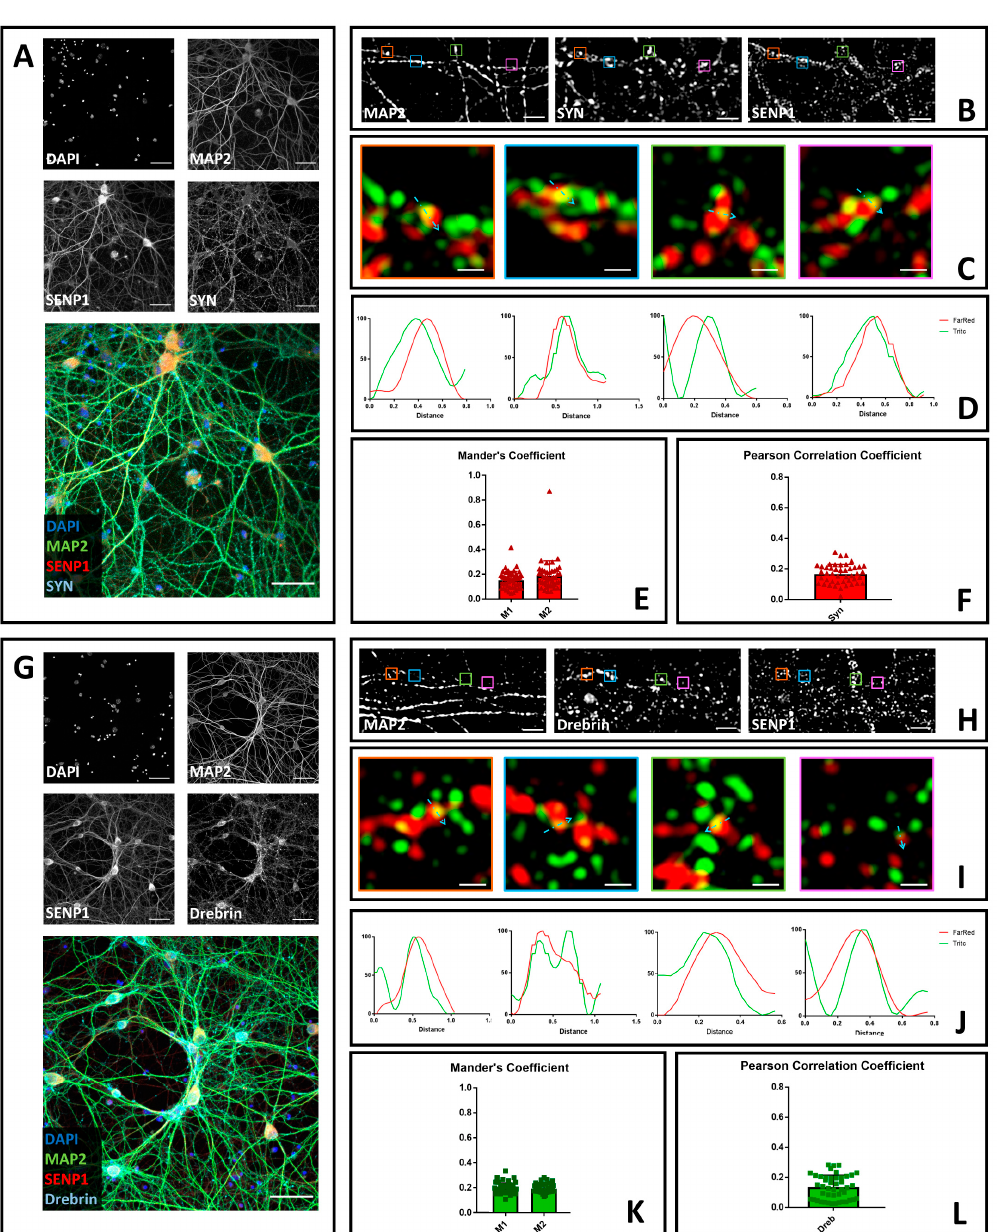
Figure 1. Confocal and structured illumination microscopy (SIM) microscopy to determine the neuronal localization of SENP1. ( A ) Neurons were fixed and stained with anti-SENP1 (red), anti-synaptophysin (light blue) and anti-microtubule-associated protein 2 (Map2) (green). Images were obtained using a Nikon N-SIM confocal microscope and overlaid to assess protein localization. Nuclei were stained with Hoechst. Scale bar of 50 µ m. ( B ) 3D-SIM images acquired with a 100 × objective. Scale bar of 2 µ m. Squares represent the location of the inset present in panel C. ( C ) Merge images of reconstructed 3D-SIM images of SENP1 (green) and synaptophysin (red). Scale bar of 0.5 µ m. ( D ) Intensity profile (green for SENP1 and red for synaptophysin) representing the values indicated by the light blue arrow in panel C. The values were normalized to 100 (arbitrary unit). ( E ) Mander’s coe ffi cients of SENP1 co-localization with synaptophysin (M1) and synaptophysin co-localization with SENP1 (M2). ( F ) Pearson’s correlation coefficient of SENP1 and synaptophysin (SYN). Data are the mean ± SD of 45 fields from three independent experiments. ( G ) Neurons were fixed and stained with anti-SENP1 (red), anti-drebrin (light blue), and anti-Map2 (green). Images were obtained using